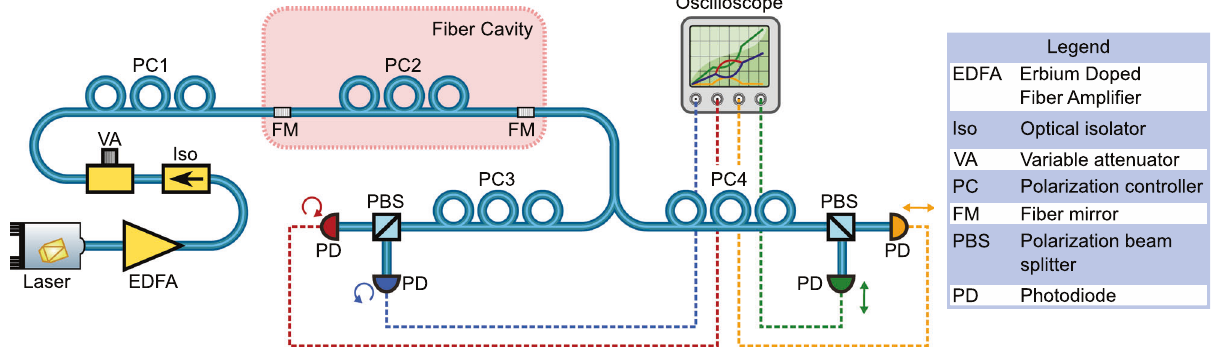
Fig. 2 Experimental setup. A high- fi nesse Fabry – Pérot fi ber cavity is realized by connecting an optical fi ber on both ends to fi bers with dielectric Bragg mirror stacks ( fi ber mirror, FM). To attain degenerate polarization modes, a polarization controller (PC2) is placed within the cavity, which is used to cancel any birefringence in the fi ber and mirrors. Light is sent into the cavity from a tunable diode laser via an erbium-doped fi ber ampli fi er (EDFA) with an isolator (Iso) to prevent back re fl ections. A variable attenuator (VA) is then used to control the power of the input light and its polarization is set by polarization controller PC1. The output of the cavity is split by a 50:50 fi ber coupler and each branch is directed to photodiodes (PD) via PC3,4 and polarization beam splitters (PBS). These fi nal PCs are used to map the cavity ’ s polarization states to the PBS such that the PDs each monitor a distinct polarization mode of the